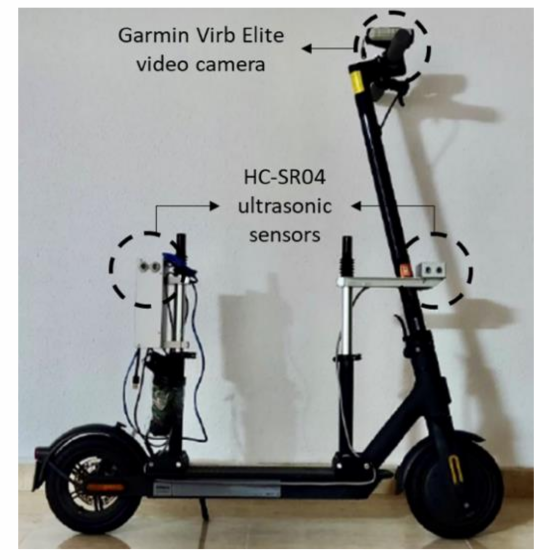
Figure 2. Instrumented